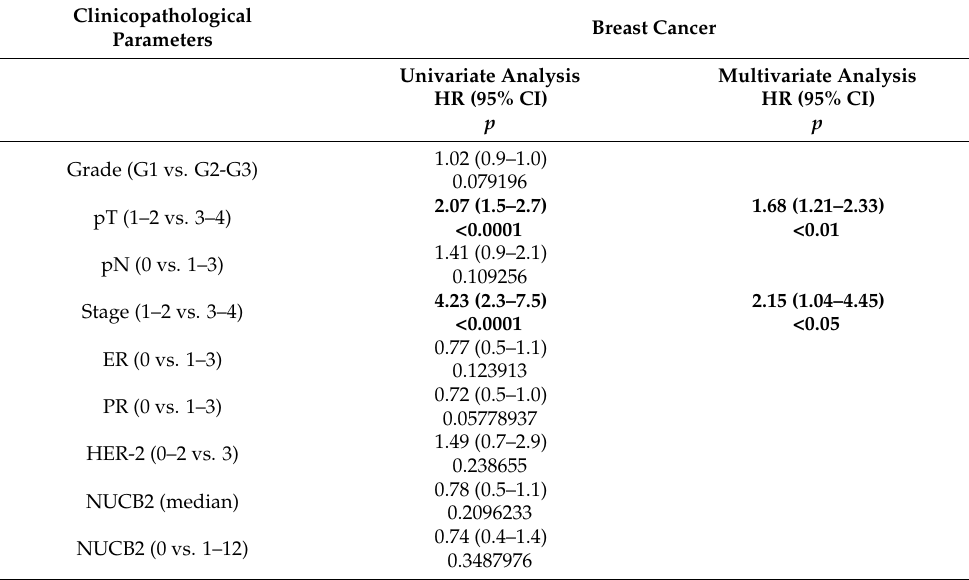
Table 1. Univariate and multivariate Cox proportional hazards’ analysis of 446 patients with breast